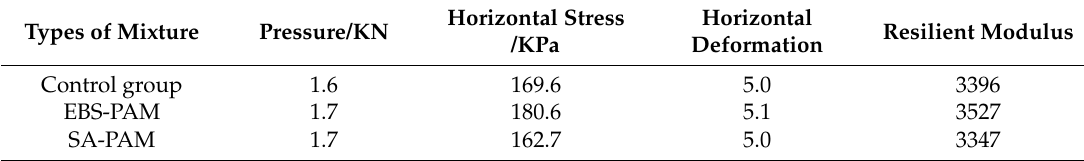
Table 11. Results of resilient